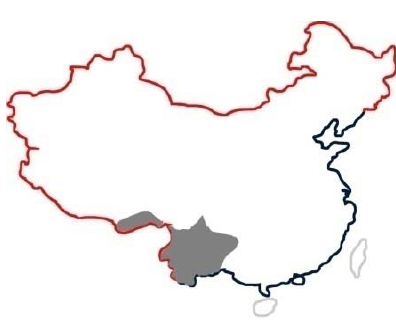
Figure 20. Moderate region map.